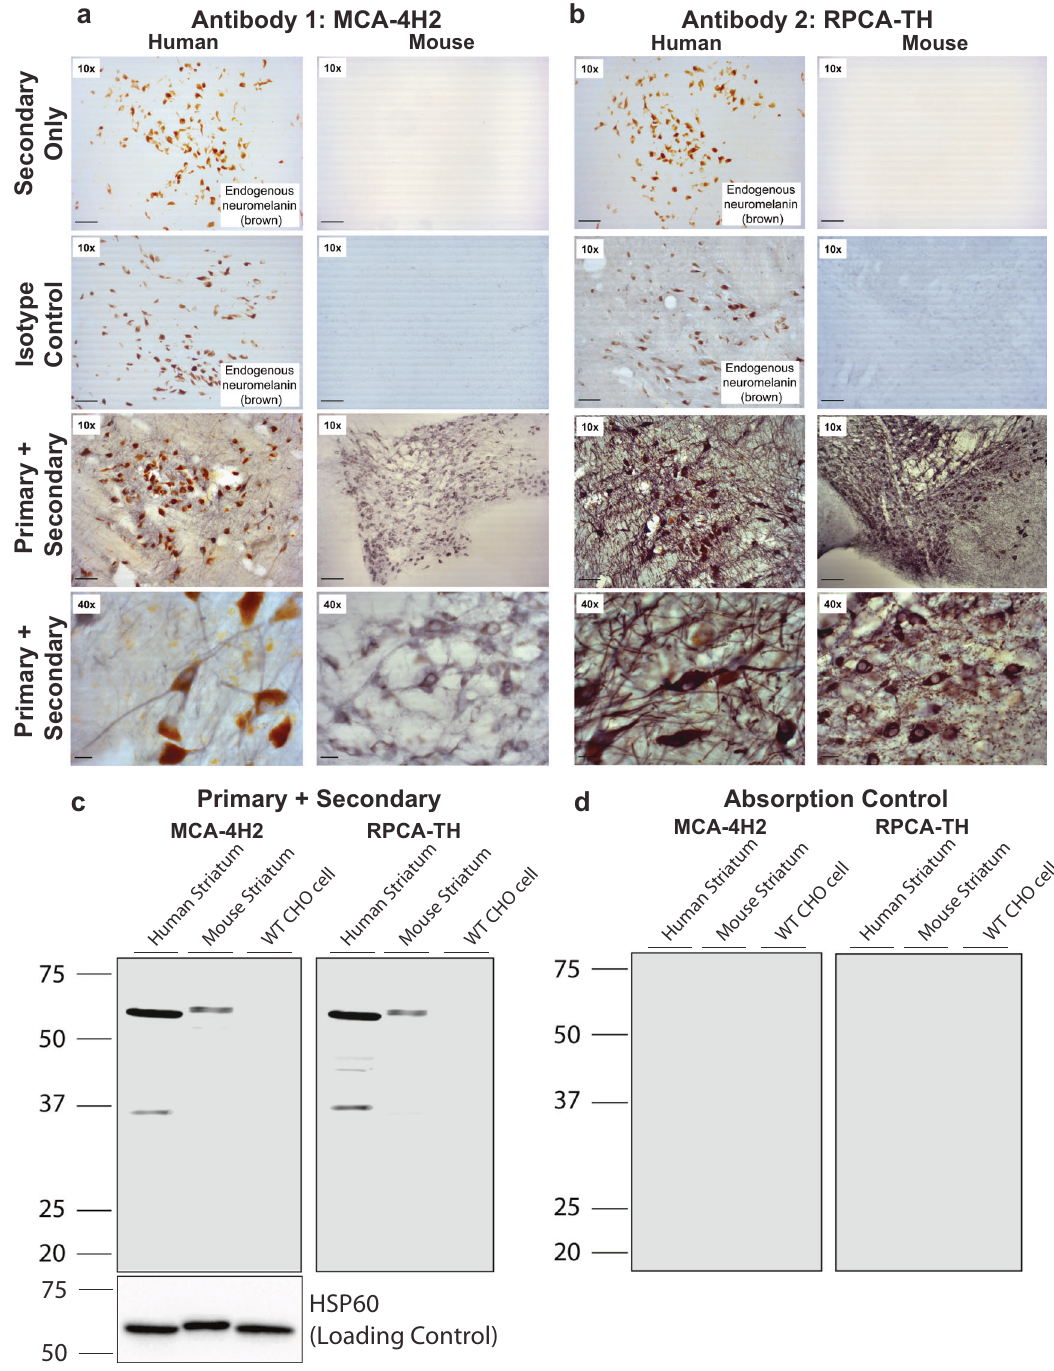
Fig. 2 Antibodies MCA-4H2 and RPCA-TH reliably detect both native and denatured TH in mouse and human tissue. Human and murine brain sections (40 µm) were permeabilized, blocked, and stained with primary antibodies (MCA-4H2 and RPCA-TH) followed by HRP- conjugated secondaries and detected using diaminobenzidine enhanced with nickel (NiDAB, gray-black). a MCA-4H2 stains neuromelanin- expressing (brown) TH positive midbrain neurons and neuronal processes (gray-black) with no non-speci fi c staining (secondary only, top panel; isotype control, second panel) in both human and murine tissues. b RPCA-TH shows similar highly speci fi c staining of midbrain TH- positive neurons, con fi rming antibody speci fi city. a and b Human midbrain tissues showed as secondary-only and isotype controls exhibit endogenous neuromelanin (brown), not to be confused with immunostaining. c Western blot analyses of murine and human striatal tissues reveal similarly speci fi c detection of TH (~63 kDa band) in both mouse and human, with minimal non-speci fi c staining in negative control homogenate (parental CHO cell homogenate). (Left — MCA-4H2, right — RPCA-TH). d Blocking peptide/absorption control followed by western blot detection with either RPCA-TH and MCA-4H2 con fi rms the speci fi city of both antibodies for TH protein. HSP60 (loading control) is shown below and applies to c and d